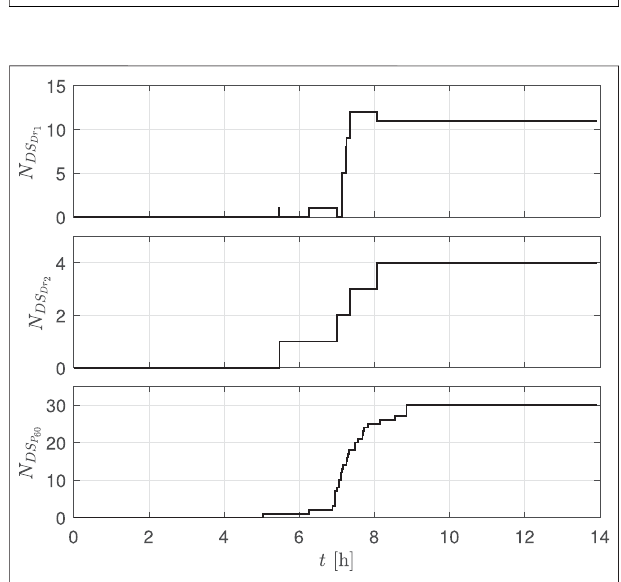
FIGURE 5 | An example of the non-stationary/-straight/-Gaussian external wind pressure process for an envelope component located at the upper-left corner of the south face of the